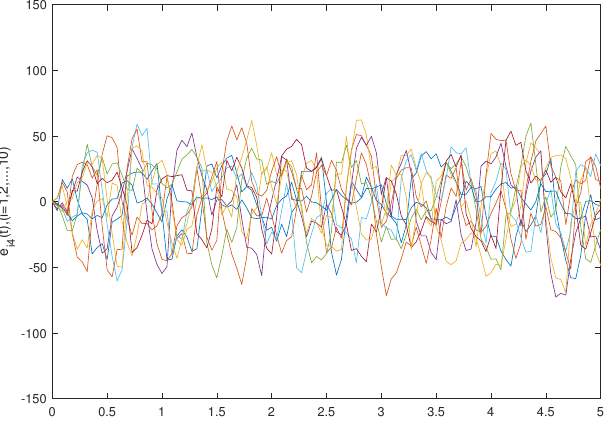
Figure 7. Synchronization errors e i 4 ( i = 1,2, · · · ,10 ) of the fractional-order system (32) and (33) without the